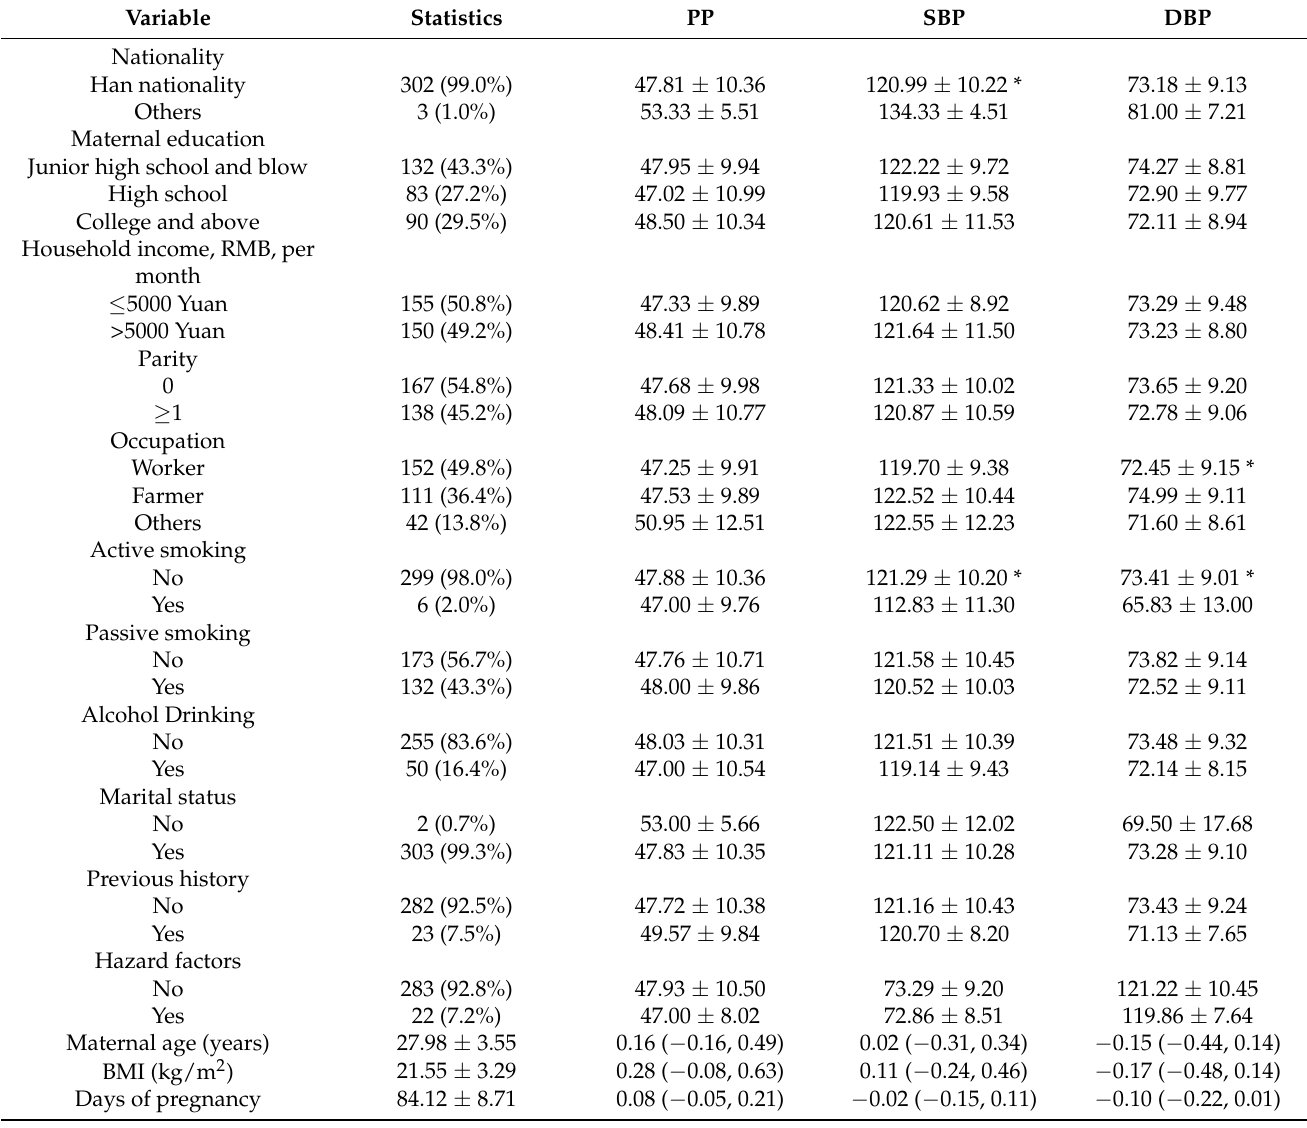
Table 1. Demographic characteristics among the study participants ( n = 305).